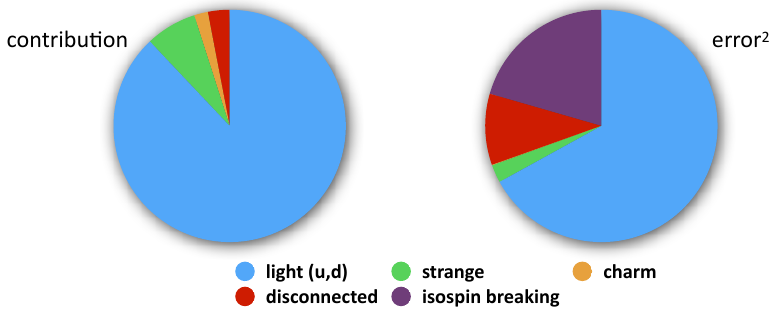
Figure 7. Individual contributions to the estimate and variance of our result in Eq.(23). While the estimate of a hvp µ does not contain the correction due to isospin breaking, the size of the correction from Ref. [48] has been added in quadrature to the